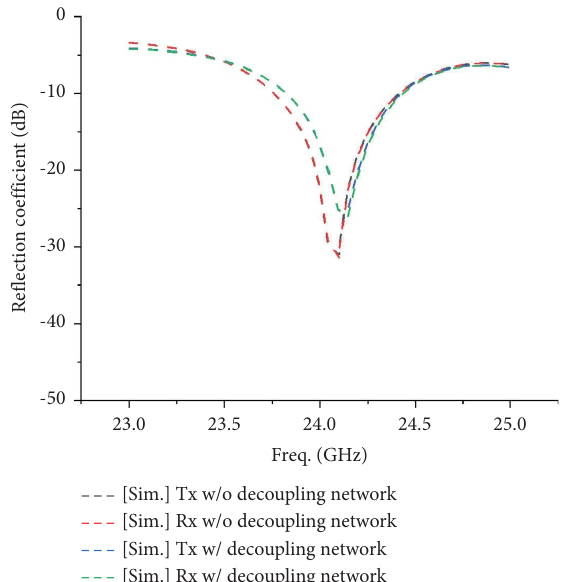
Figure 11: Refection coefcients of the Tx/Rx antennas without and with the decoupling network.